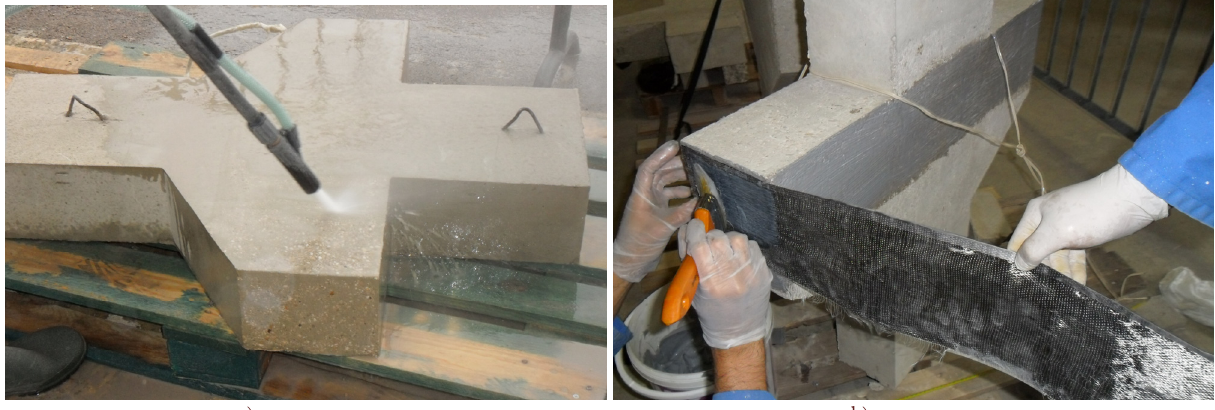
Figure 2: Details of bonding system of: a) Sandblasting of corbels and b) Application of carbon fiber on concrete surface by wrapping.